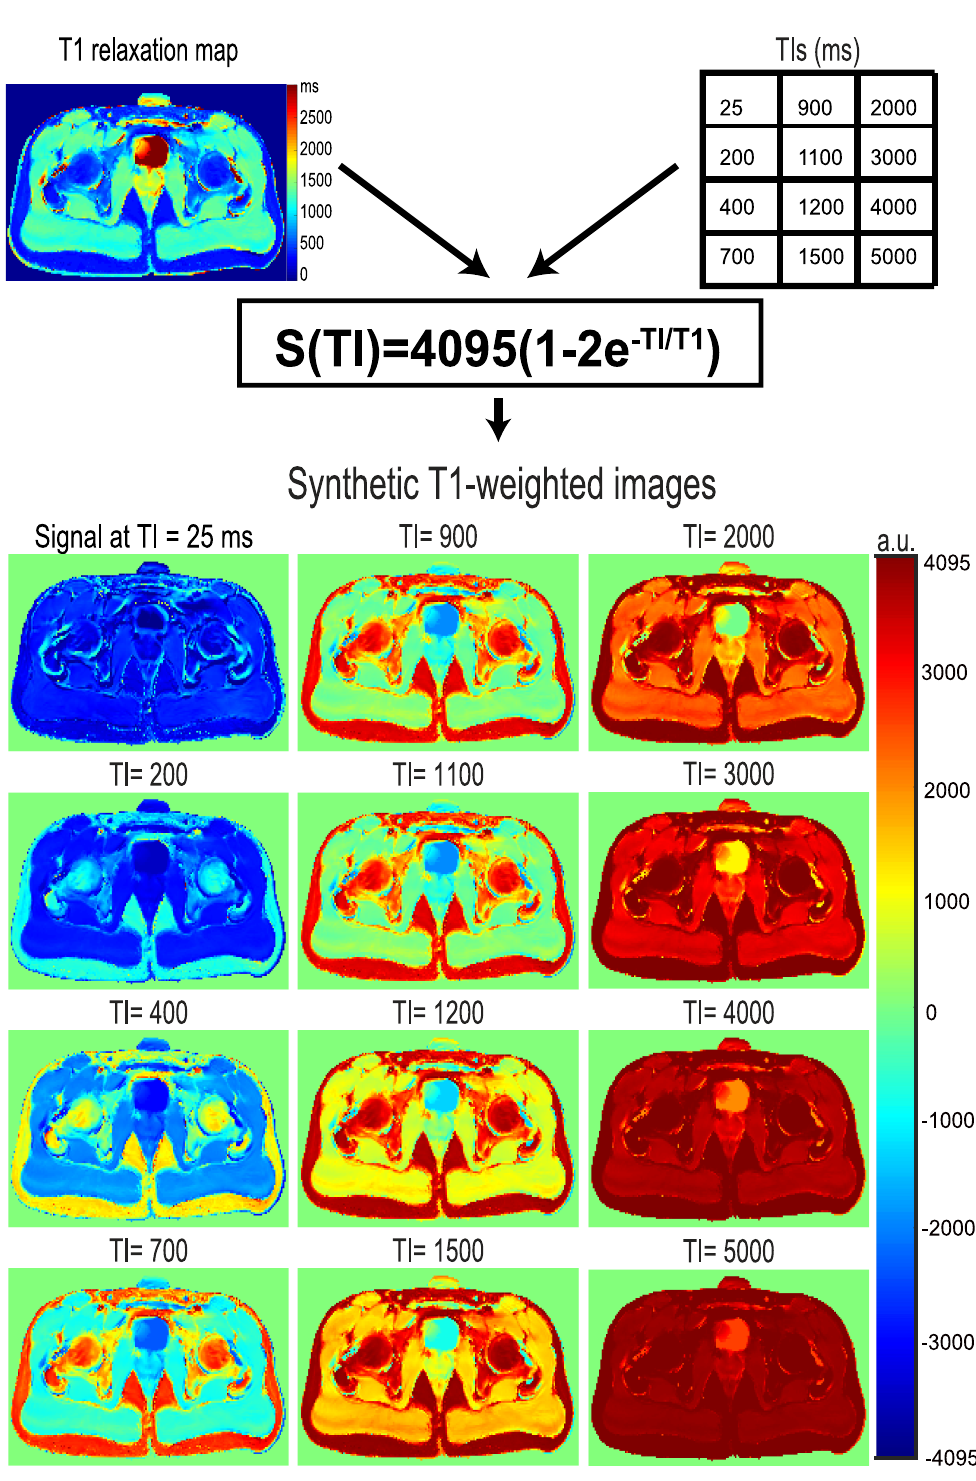
Fig 4. Process by which the synthetic T 1 -weighted image is computed. The relaxation times of tissues and the selected inversion times (TI) are used to generate the synthetic T 1 -weighted images using the model describing a received signal from a perfect inversion